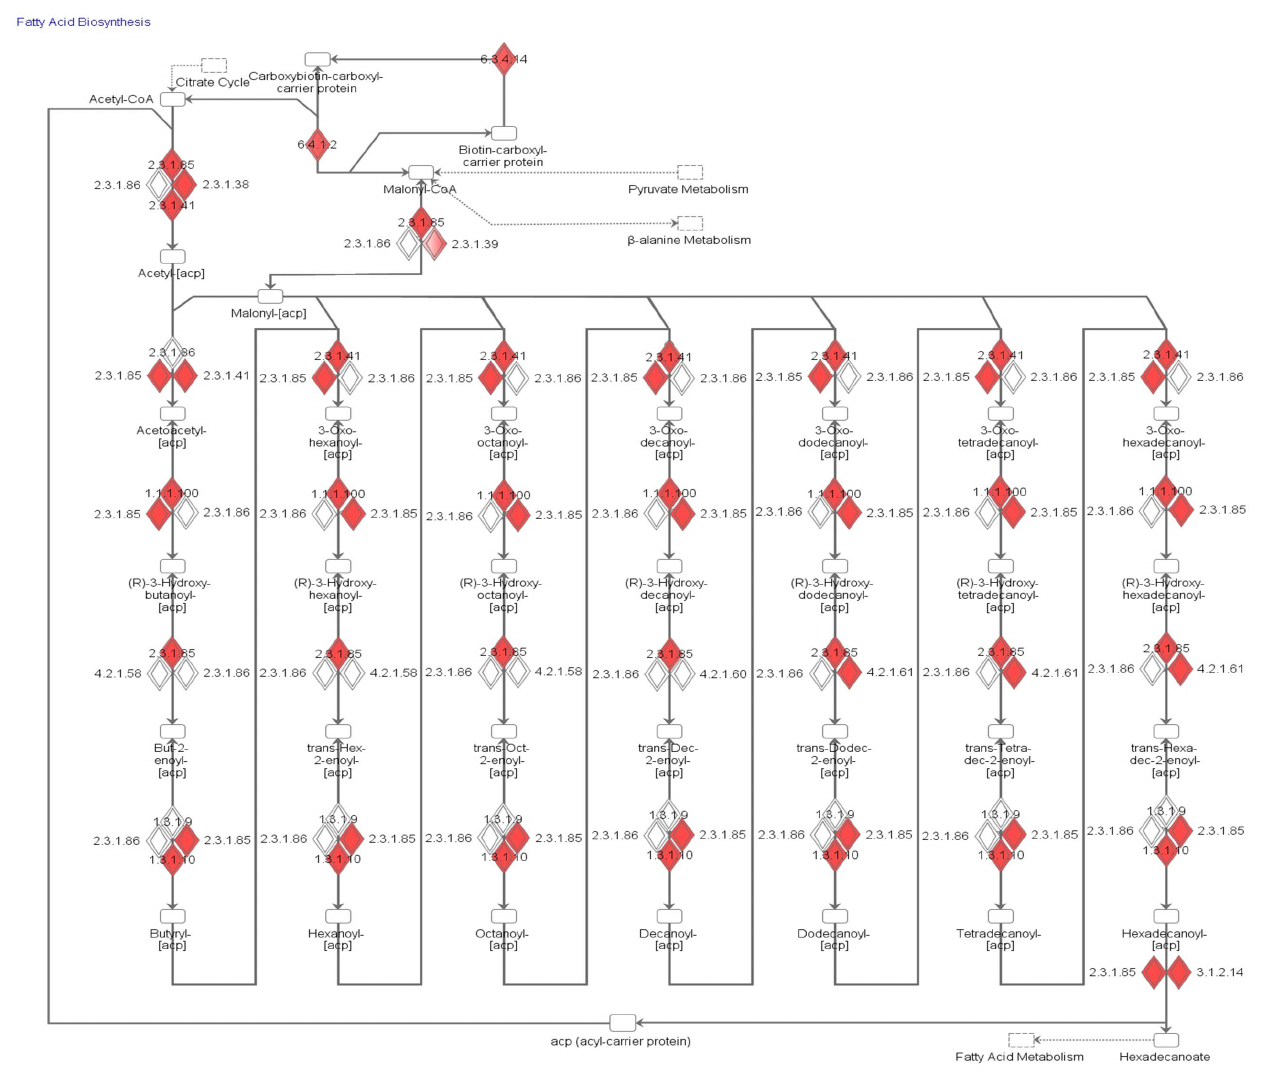
Figure 6. Canonical biosynthesis pathway of fatty acids in liver using microarray data. Mapping of gene expression for liver tissues on biosynthesis of fatty acids, using Ingenuity Pathway Analysis software. Red color shows upregulated gene expression in MKR mice versus Healthy mice.